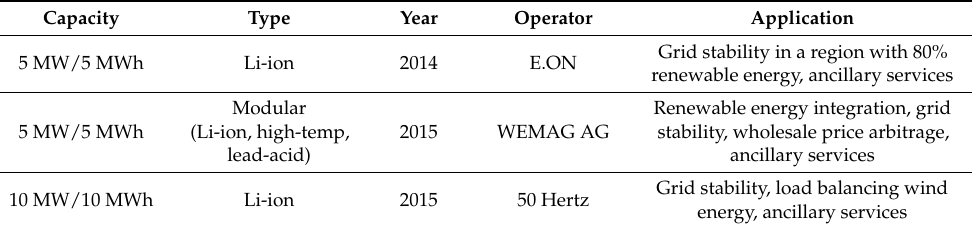
Table 3. Key wholesale market battery storage projects [32].